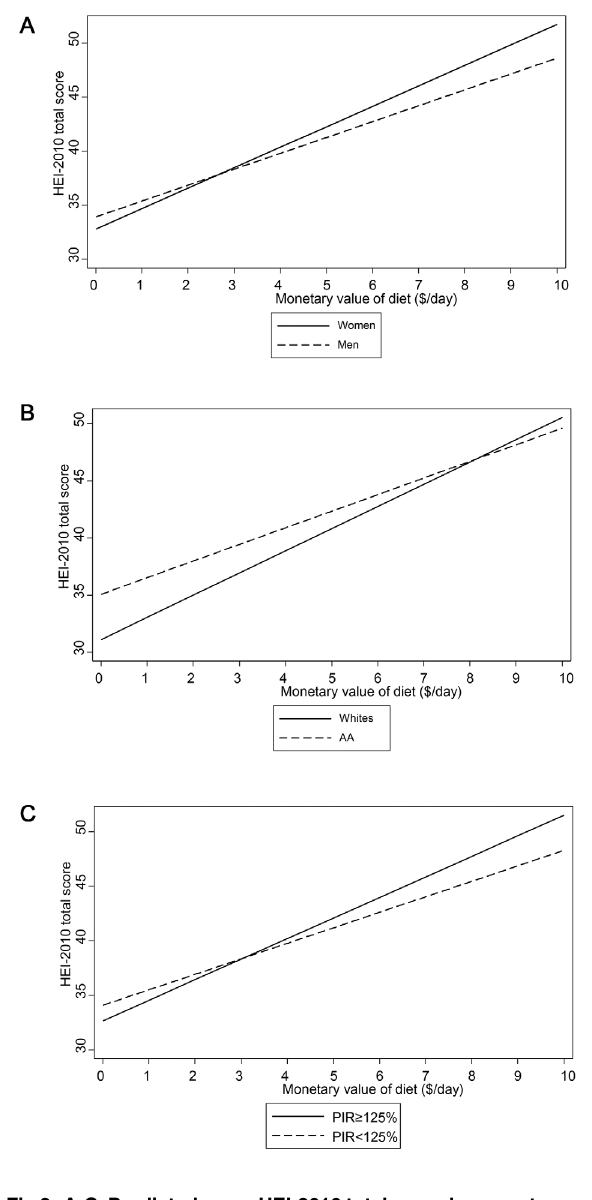
and poverty status c HANDLS study, wave 1. a p < 0.10 for MVD×sex interaction; b p < 0.10 for MVD×race interaction; c p < 0.10 for MVD×pov